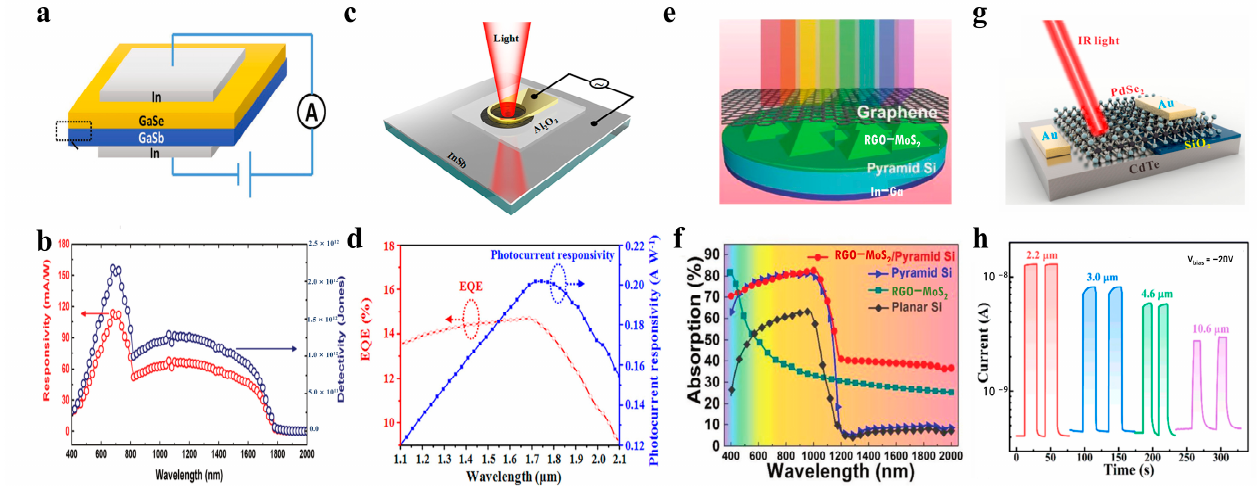
Figure 4. Broadband infrared photodetection. ( a ) Schematic diagram of p-GaSe/n-GaSb vertical het- erostructure detector [83] (copyright 2017, John Wiley and Sons). ( b ) Wavelength-dependent photore- sponsivity of GaSe/GaSb detector [83] (copyright 2017, John Wiley and Sons). ( c ) Schematic diagram of ultra-broadband Gr/InSb heterostructure photodetector [84] (copyright 2017, AIP Publishing). ( d ) Current–voltage characterizations of Gr/InSb heterostructure photodetector (473 nm– 10µm) [84] (copyright 2017, AIP Publishing). ( e ) Schematic diagram of RGO–MoS 2 /pyramid Si detector [85] (copyright 2018, John Wiley and Sons). ( f ) UV–NIR absorption spectra of RGO–MoS 2 /pyramid Si detector [85] (copyright 2018, John Wiley and Sons). ( g ) Schematic diagram of PdSe 2 /CdTe heterojunction infrared detector for broadband to 10.6µm [82] (copyright 2021, American Chemical Society). ( h ) Photoresponse properties of PdSe 2 /CdTe detector [82] (copyright 2021, American Chemical Society).